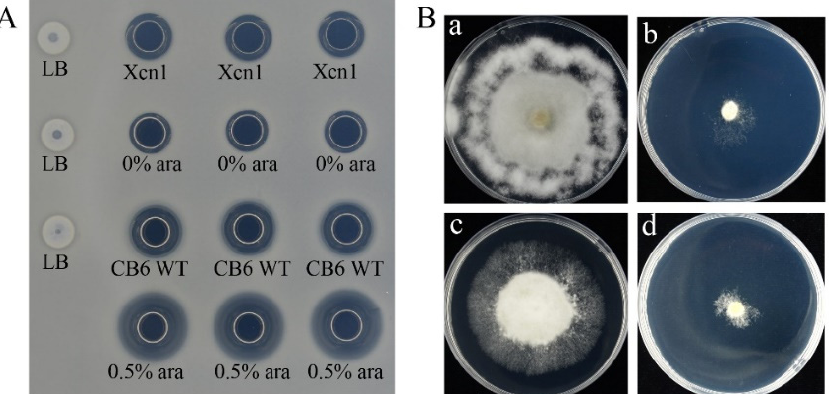
Figure 5. The antimicrobial activity of wild type CB6 strain and ∆ P BAD -xcnA mutant strain on B. subtilis and P. capsici. ( A ) Antibacterial activity was studied by agar diffusion plate assay using B. subtilis as the indicator. Xcn1 represents 50 µ g/mL Xcn1, CB6 WT represents the cell-free fermen- tation broth of wild type strain, 0% ara and 0.5% ara represent the cell-free fermentation broth of uninduced and induced ∆ P BAD -xcnA mutant, respectively. ( B ) Antifungal activity of ∆ P BAD -xcnA mu- tant was assessed by growth inhibitory assay using P. capsici as the indicator. ( a ) control, ( b ) 137-fold dilution of the fermentation broth of wild type CB6 strain mixed with PDA medium with a final concentration of 0.5 µ g/mL of Xcn1, ( c ) 137-fold dilution of the fermentation broth of uninduced ∆ P BAD -xcnA mutant mixed with PDA medium, and ( d ) 500-fold dilution of the fermentation broth of ∆ P BAD -xcnA mutant induced by 0.5% L-arabnose mixed with PDA medium with a final concentration 0.5 µ g/mL of Xcn1. Table 3. Inhibitory effect of the cell-free fermentation broth against B. subtilis and P. capsici. Samples Inhibition Zone Against Samples